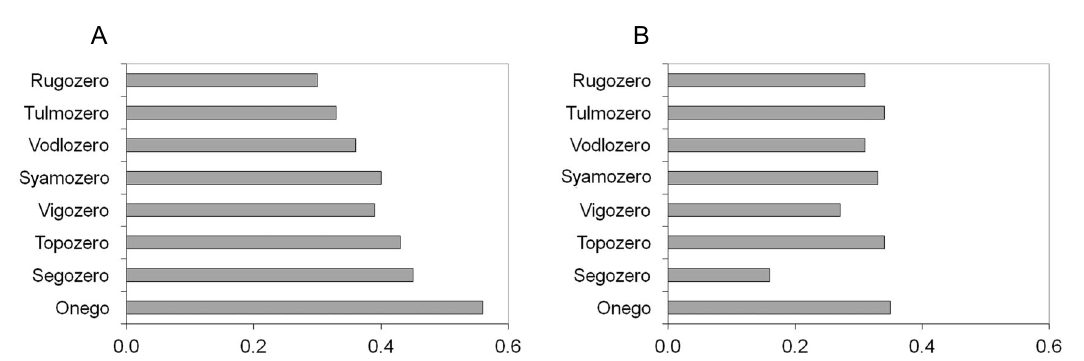
Fig. 2. Correlation coefficients (absolute values) between NAOI (January(cid:150)February) and the break-up dates ( A ); between NAOI (October, November) and freezing dates ( B ) in 1950(cid:150)2009. Lakes are listed from top to bottom according to increasing water volume. Table 2. Limnological features of the Karelian lakes